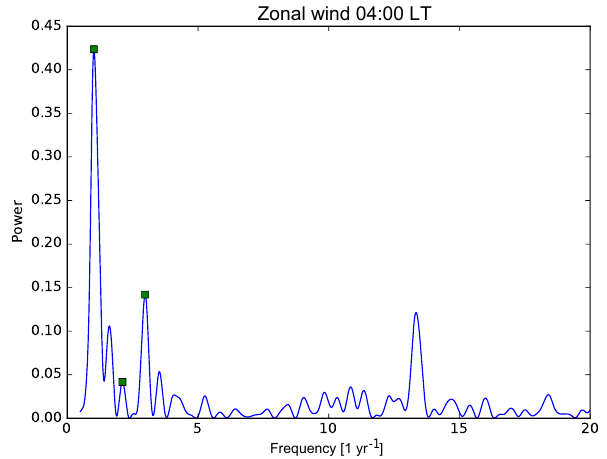
Figure 7. A Lomb–Scargle periodogram of zonal winds over Oukaïmeden Observatory at 04:00LT. The squares represent the lo- cations of the annual, semiannual, and terannual harmonics.